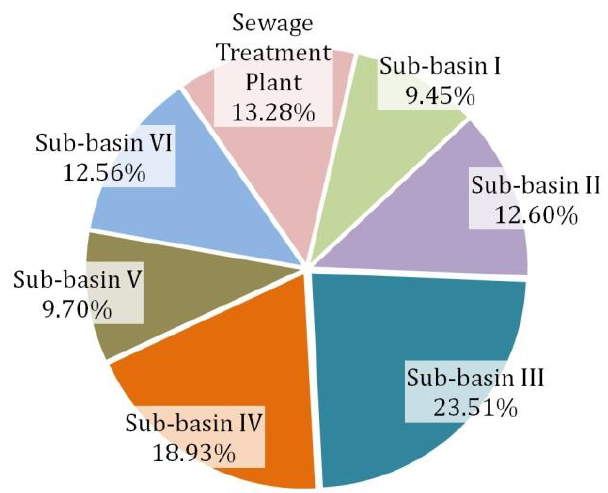
Figure 7. Contribution weight of each sub-basin in Fuzhou.